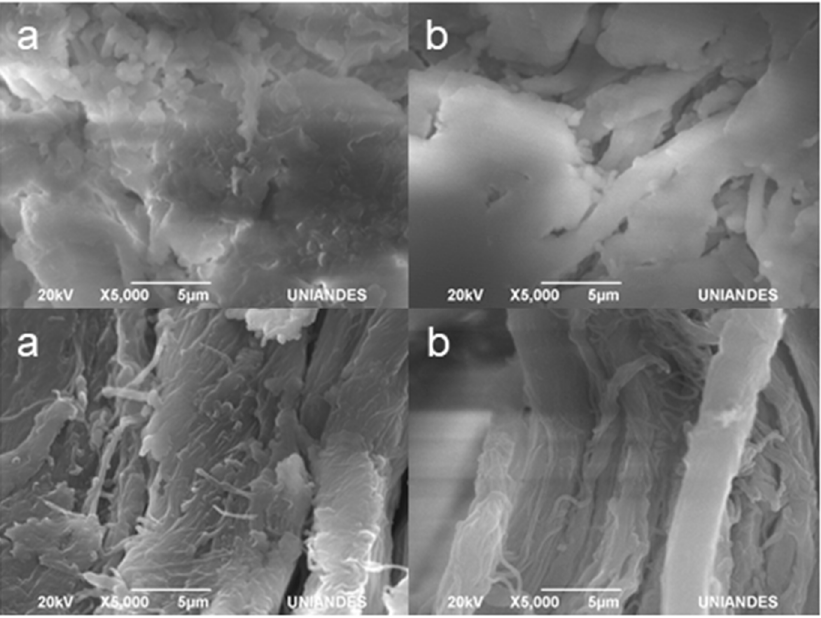
Figure 15. SEM photographs of APTES L1 (Top) and L2 (Bottom) before ( a ) and after ( b ) dye exposure.